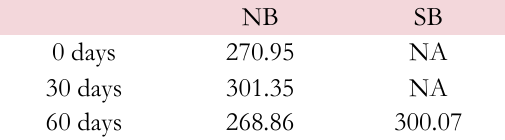
Table 8: Fatigue limit